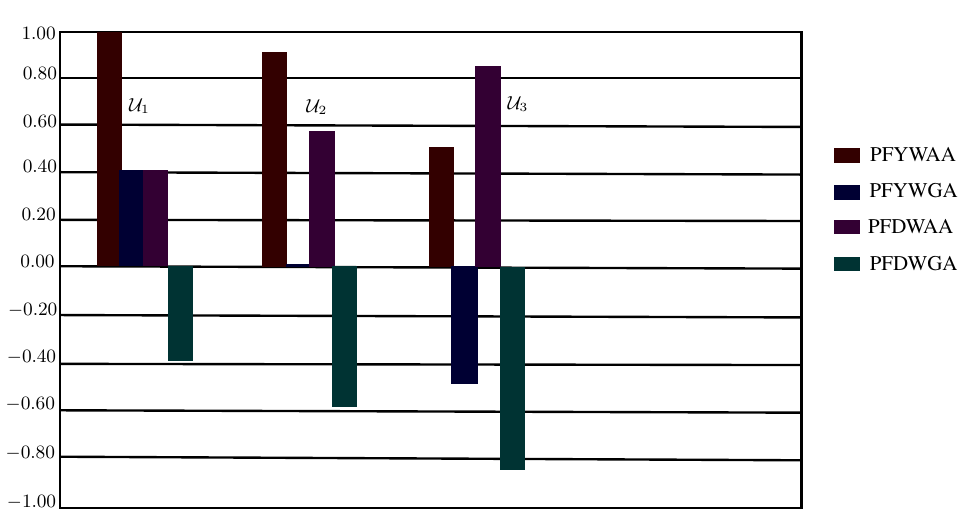
Figure 4. Four methods’